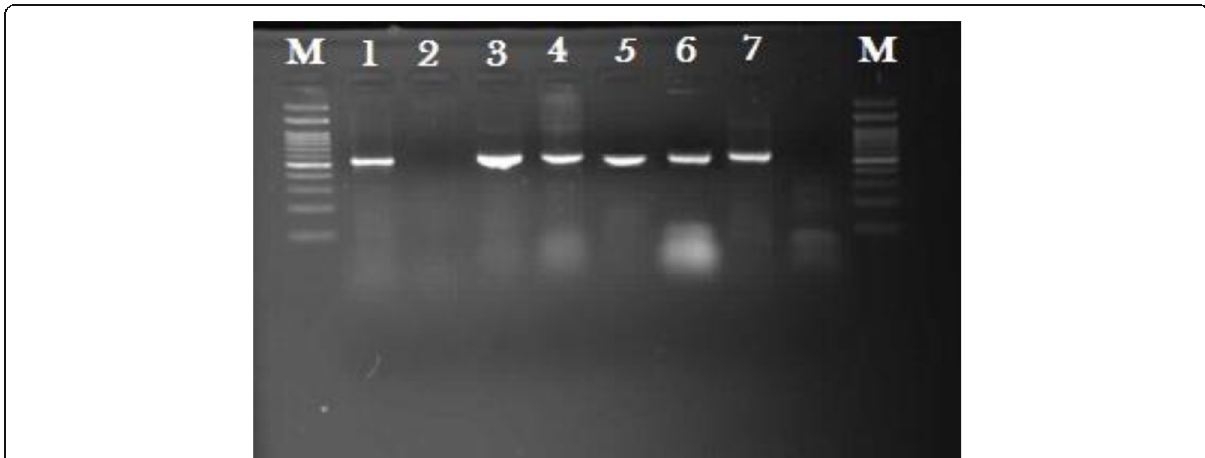
Fig. 1 Gel electrophoresis shows (from right to left) DNA ladder fragments of (1) Fusarium equiseti , (3) F. chlamydosporum , (4) F. oxysporum , (5) Alternaria alternata , (6) A. alternata , and (7) A.